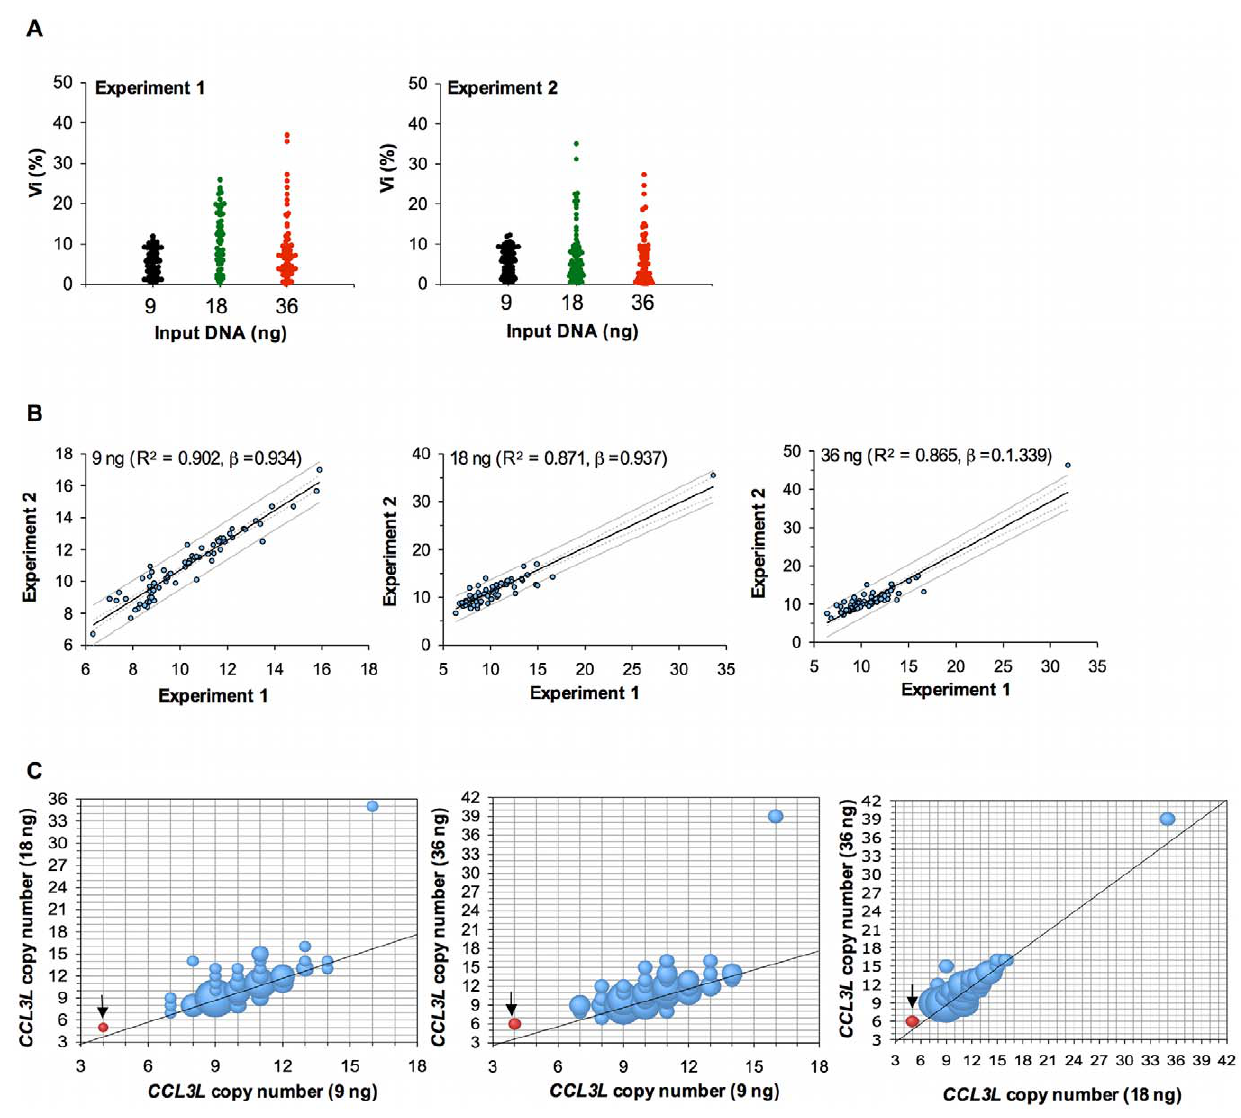
Figure 1. Intra-experiment reproducibility and inter-experiment variability in CCL3L copy-number determination. (A) Intra-experiment reproducibility as determined using duplicates for each DNA sample from 84 rhesus monkeys. The results of two separate experiments are shown. (B) Inter-experiment variability. CCL3L copy numbers were determined by real-time qPCR using different amounts of input DNA. Correlations between the mean of the unrounded CCL3L copy number estimates from two separate experiments are shown. (C) Bubble plots showing the concordance between rounded CCL3L copy number estimates determined using different amounts of input DNA. The precision of each assay was determined by the rounded CCL3L copy number estimate of from reference sample, the A431 human cell line (black